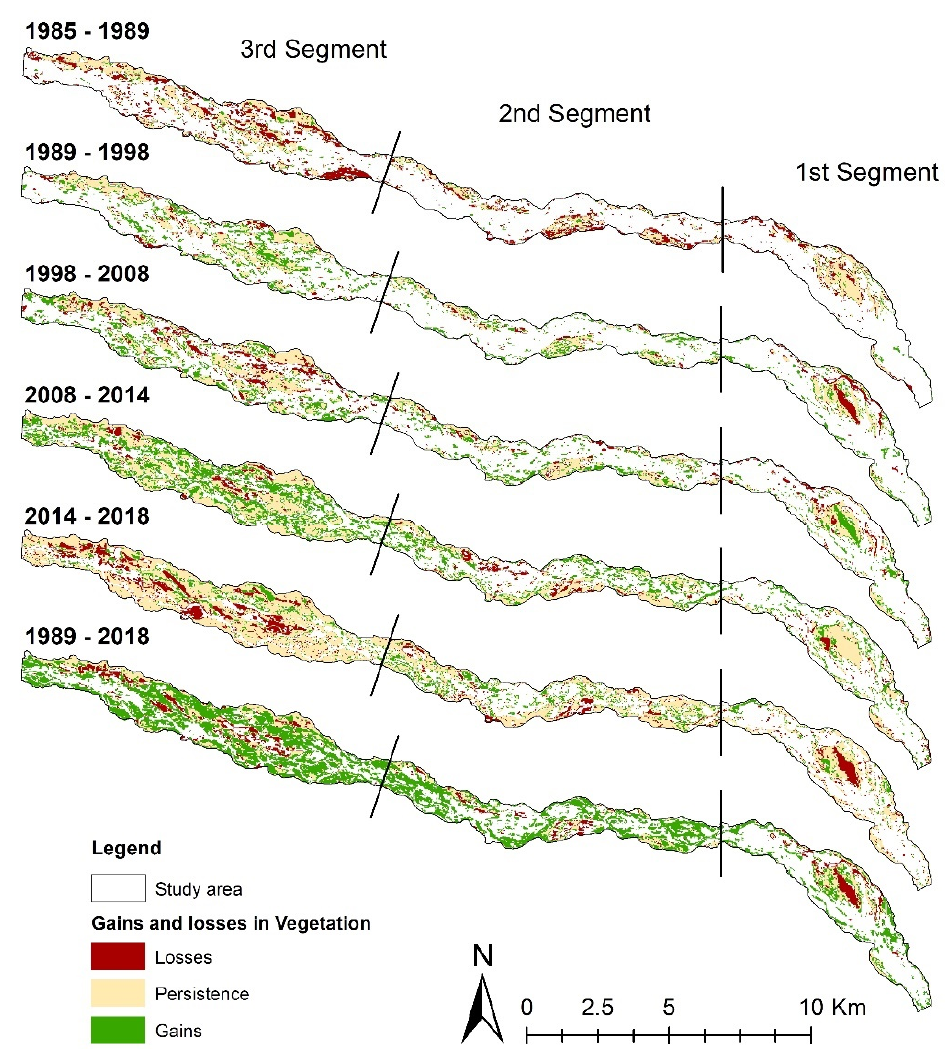
Figure 7. Distribution of losses and gains in vegetation cover.